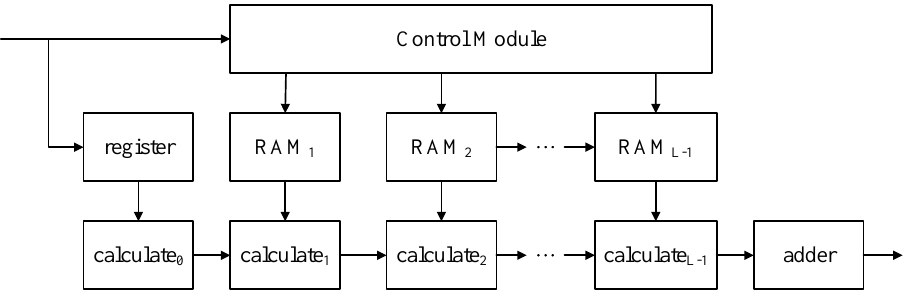
Figure 4. The architecture of channel calibration modules.